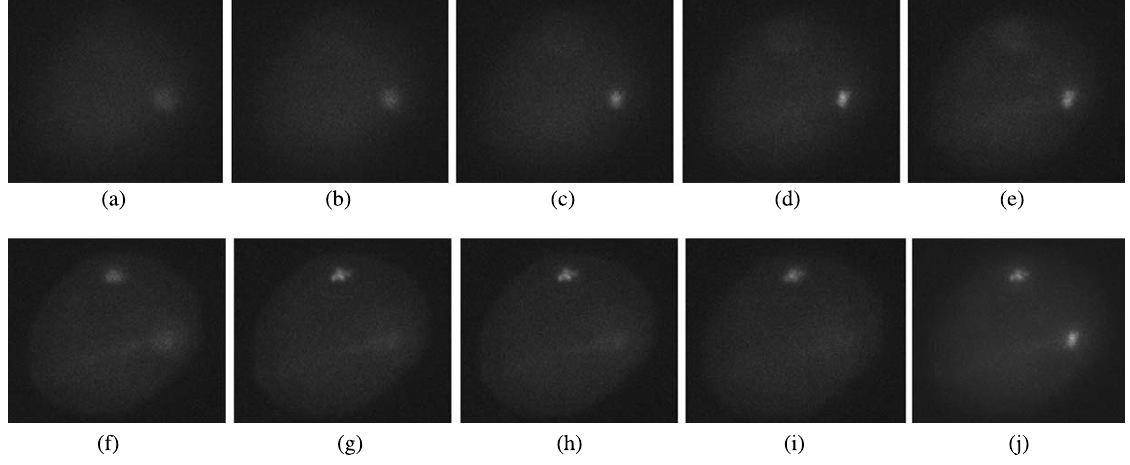
Fig. 4. An example of a stack of FISH signal image slices captured in the second FISH signal targeted spectrum in 9 focal planes (from (a) to (i)) and an integrated 2-D projection image (j) by the MIP method.